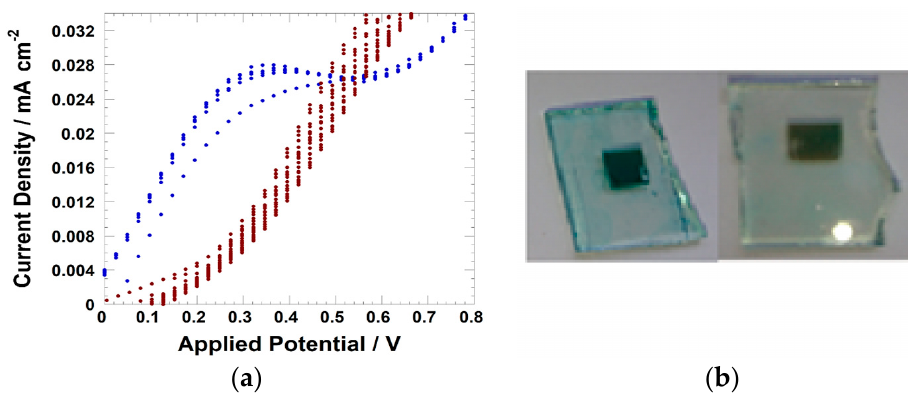
Figure 3. ( a ) Zooming of the voltammograms of the bare NiO (blue trace) and FG-sensitized NiO (brown-reddish dots); ( b ) Photograph of FG-sensitized NiO prior the treatment of electrochemical cycling (colored sample on the left) and after electrochemical cycling (bleached sample on the right). The peak of FG oxidation overlaps with the oxidation process of NiO reported in Equation (2).